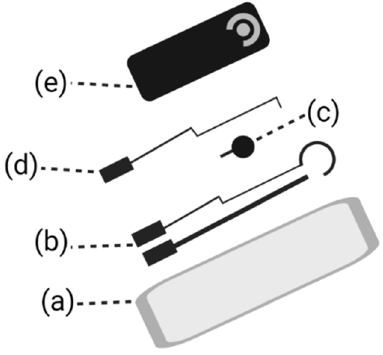
Figure 2. Manufacturing scheme for screen-printed electrodes: ( a ) substrate (polyester, ceramic, alumina, etc.); ( b ) Ag connectors; ( c ) carbon layer; ( d ) Ag/AgCl layer and ( e ) insulating layer. Created with BioRender.com accessed on 11 October 2021 .